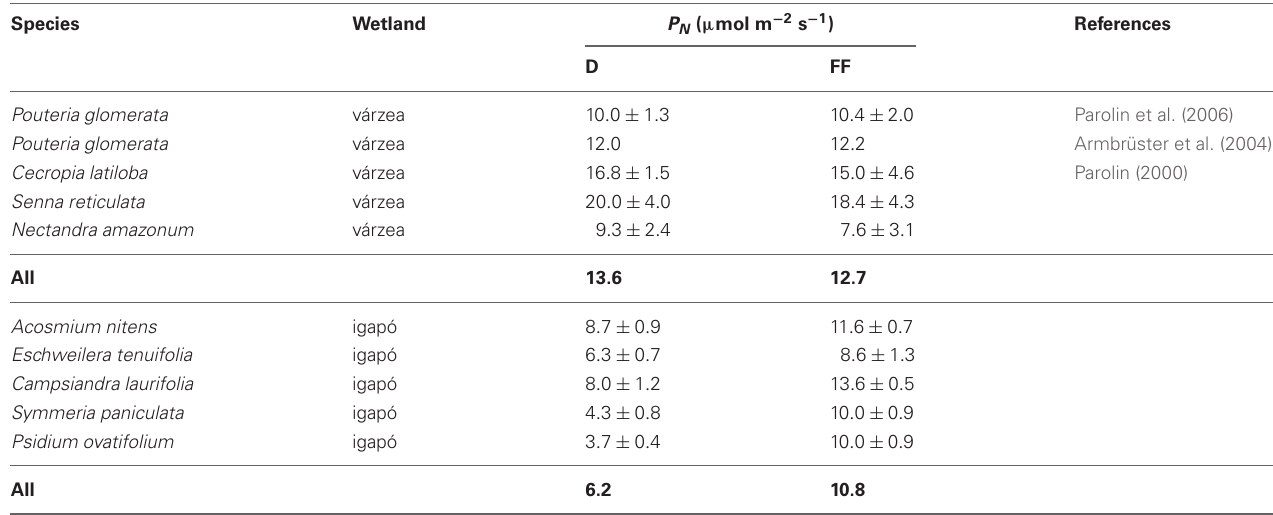
Table 2 | Maximum values of photosynthetic rate in evergreen trees growing in a várzea and an igapó during drainage (D) and flooding (FF). Species